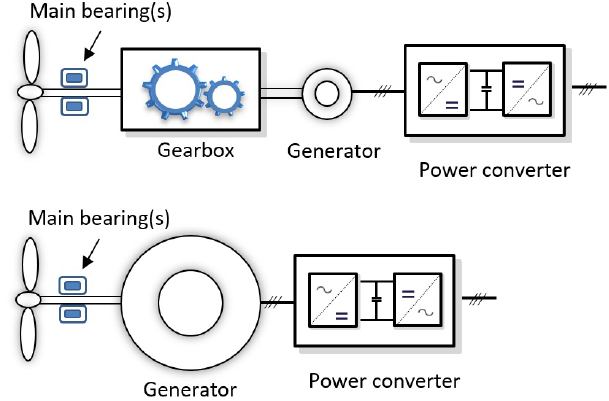
Figure 1. Schematic of the two most common types of drivetrain configurations, with and without a gearbox (illustration by Amir